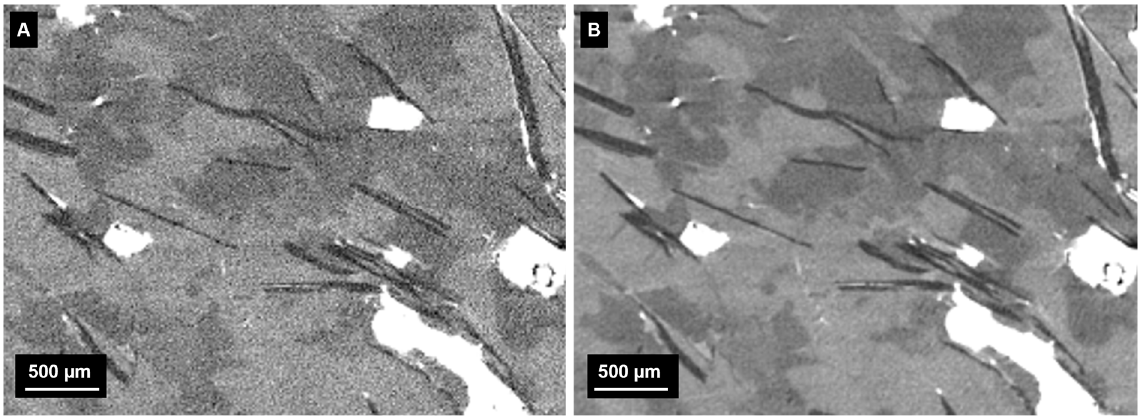
Figure 2. CT volume slice before ( A ) and after image filtering ( B